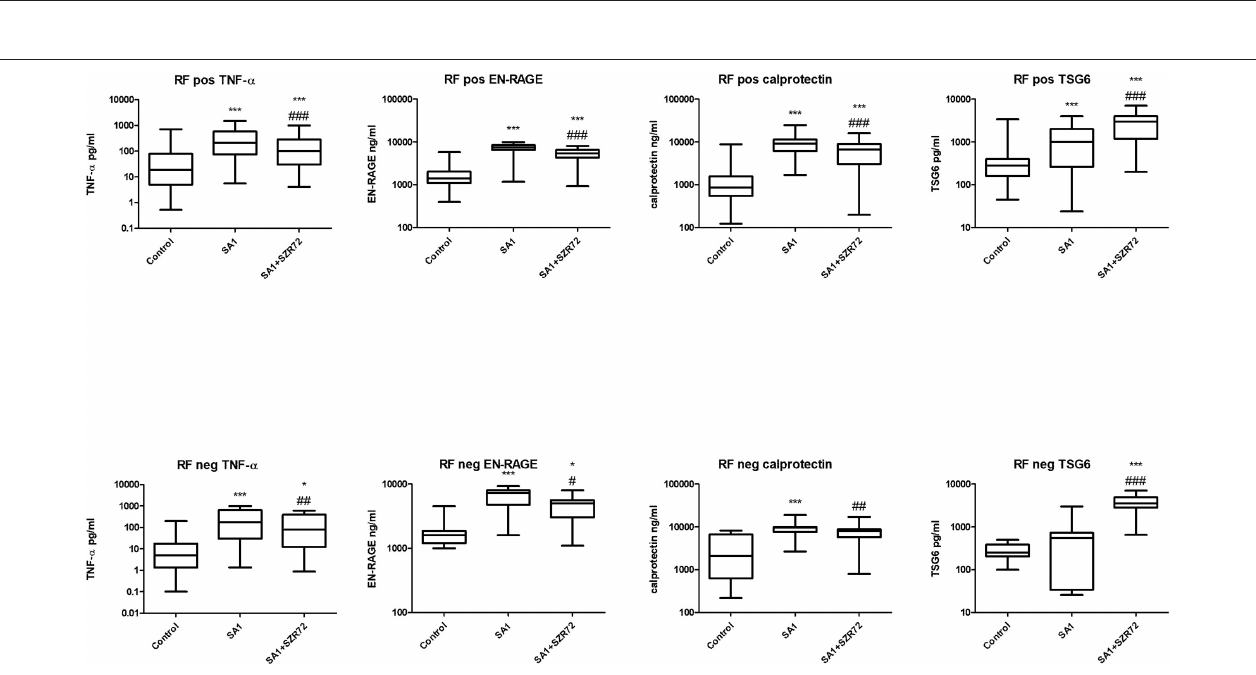
Frontiers in Immunology |